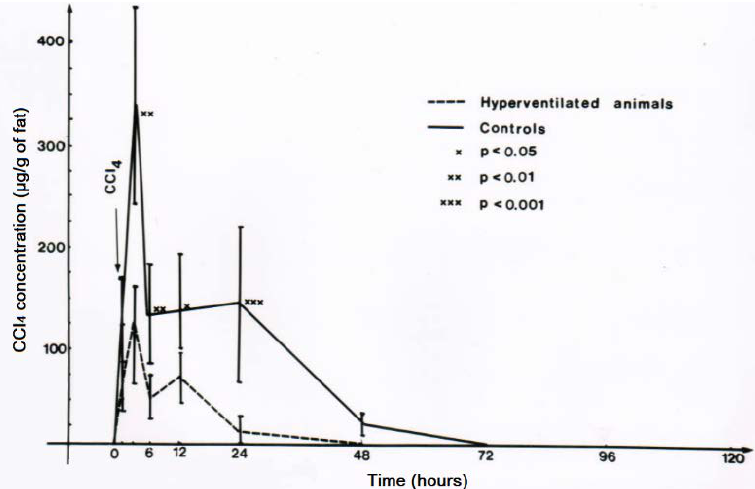
Figure 17. Experimental hyperventilation reduces CCl 4 in the fat tissue where it is soluble and can be quantified, reproduced with permission from [43]. Copyright Springer, 1983.